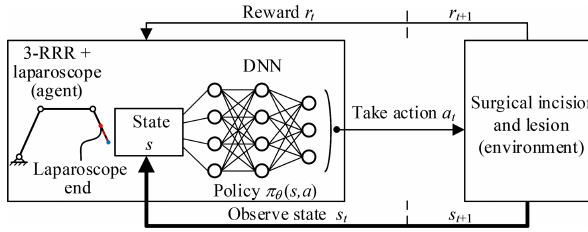
Figure 13. The agent–environment interaction in reinforcement